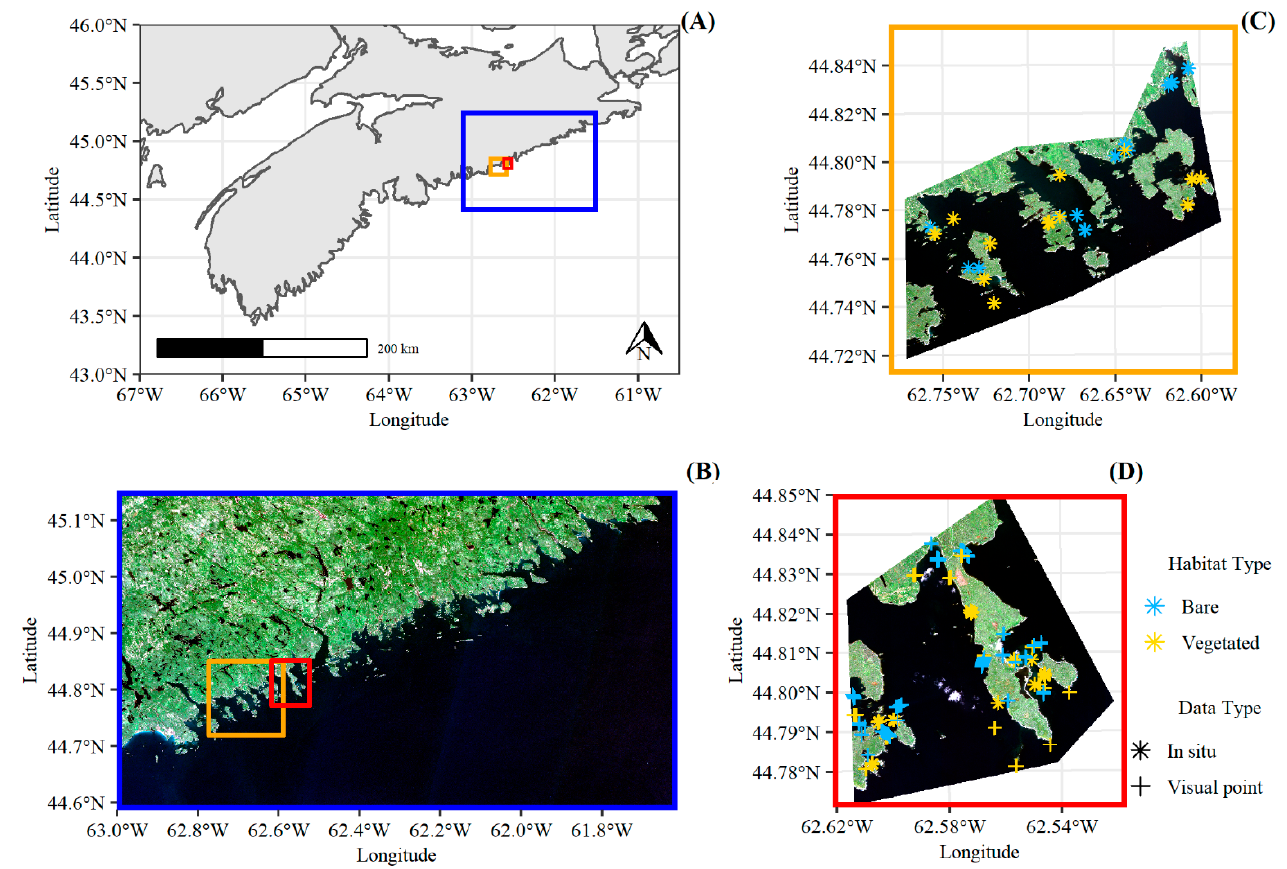
Figure 1. Study area along the Atlantic coast of Nova Scotia, Canada ( A ), and locations of the true colour composites of Sentinel-2 imagery collected on 13 September 2016 (Blue rectangle; ( B )), WorldView-3 imagery collected on 11 August 2019 (orange rectangle; ( C )), and WorldView-3 imagery collected on 17 August 2019 (red rectangle; ( D )). Locations of field survey information in WorldView-3 images ( C , D ) indicate bare bottom versus vegetated habitat for points collected in situ or visually identified from the satellite imagery.